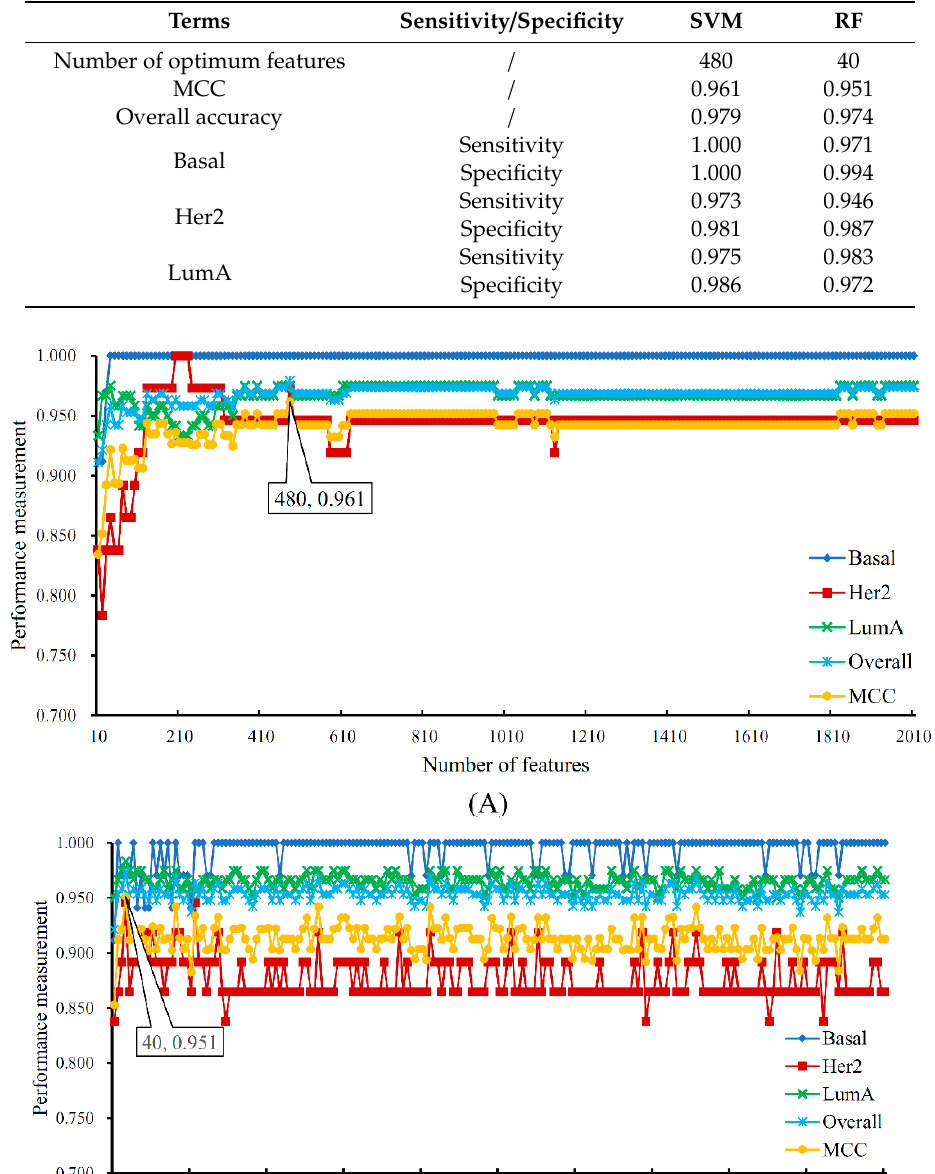
Table 2. Performance and optimum number of features of IFS with SVM and RF on the dataset without LumB samples.